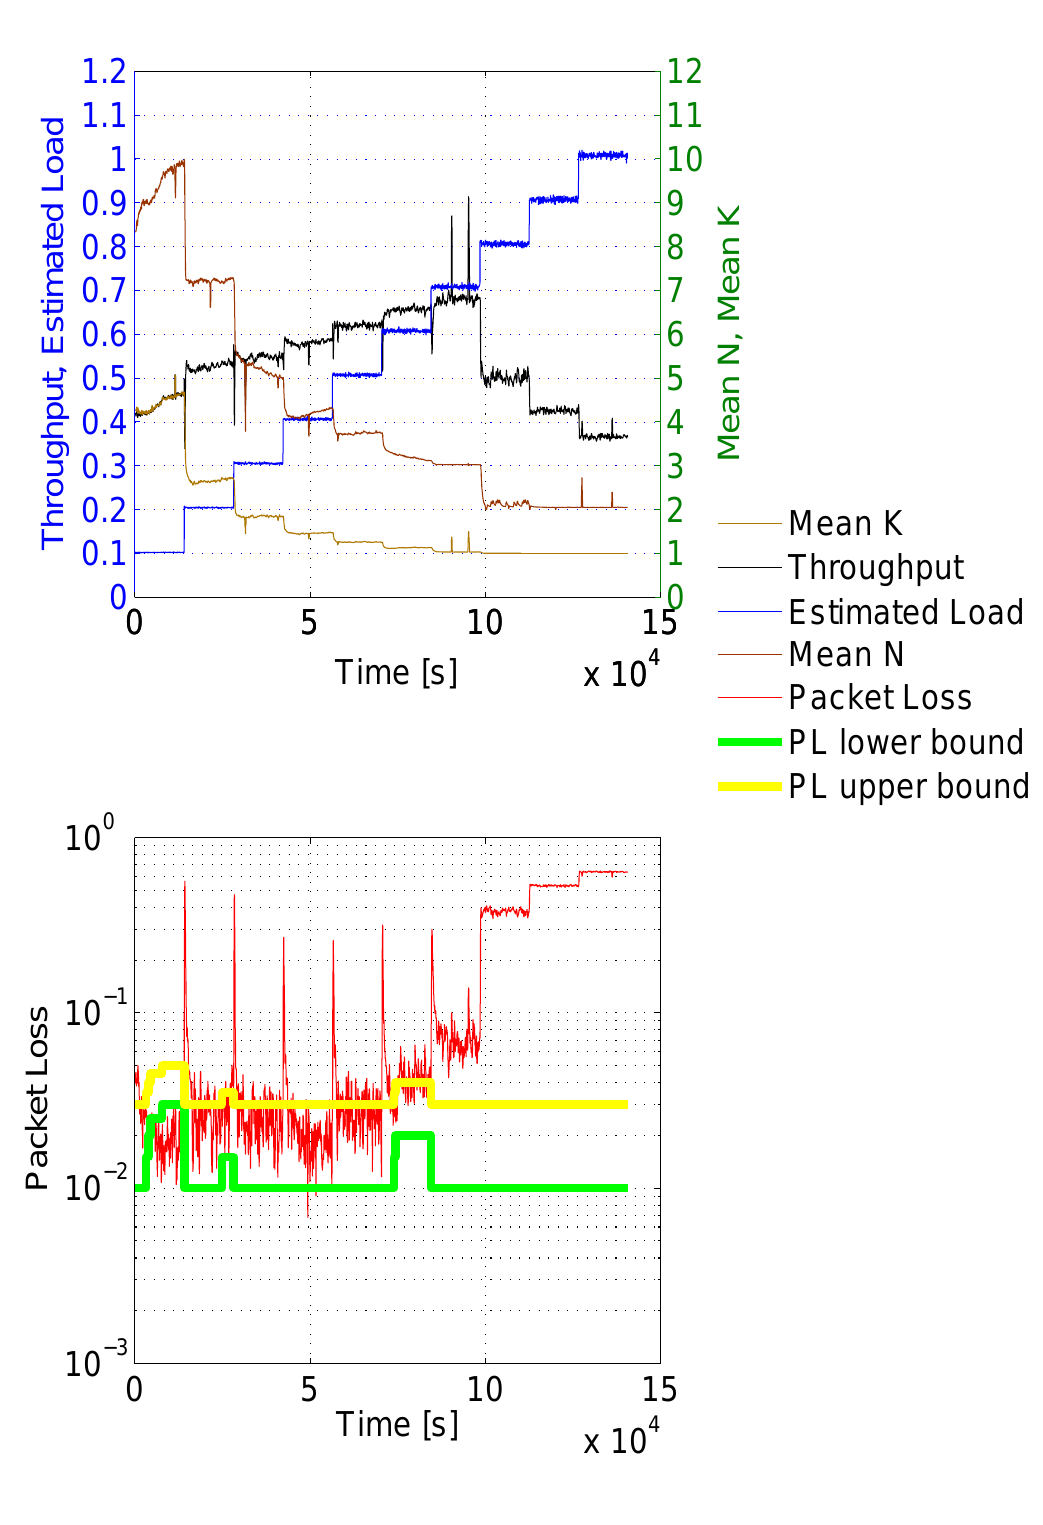
Figure 10. Throughput and Packet Loss for LC algorithm, linear code set C as in table ??